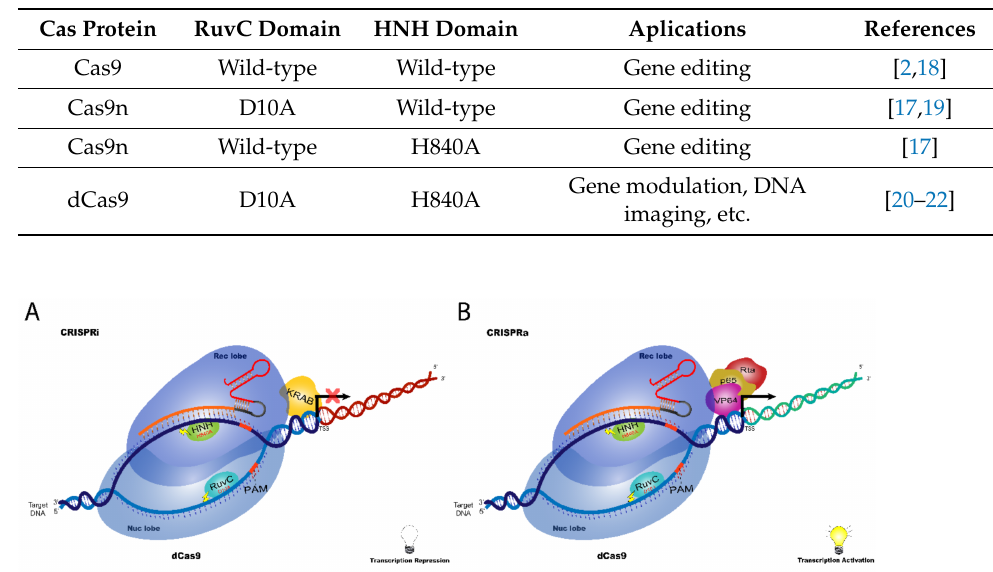
Figure 4. Gene modulation with CRISPR/dCas9 system. Dead Cas9 (dCas9) as a tool to modulate gene expression without gene editing. ( A ) In CRISPRi (interference) system, dCas9 is fused to transcriptional inhibitors such as KRAB that blocks transcription of sgRNA targeted region; ( B ) In the CRISPRa (activation) system, dCas9 is fused to transcriptional activators such as VP64, RTA and P65 to induce the expression of sgRNA targeted